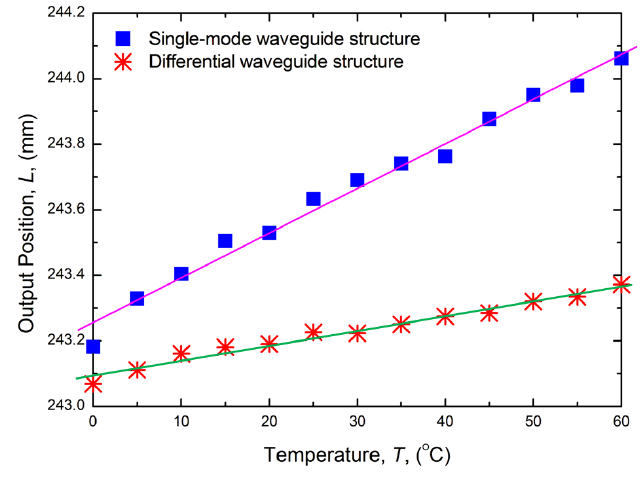
Figure 12. Comparison of temperature drift curve.